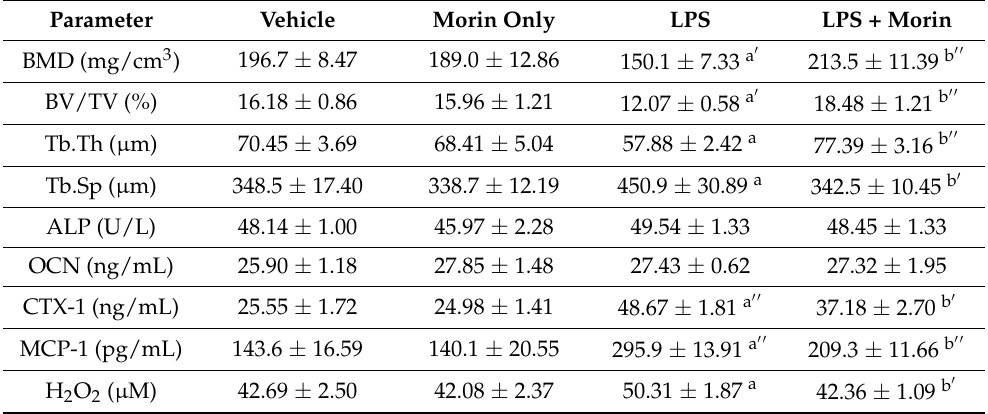
Table 1. Trabecular microarchitecture and biochemical markers of LPS with or without morin treatment in